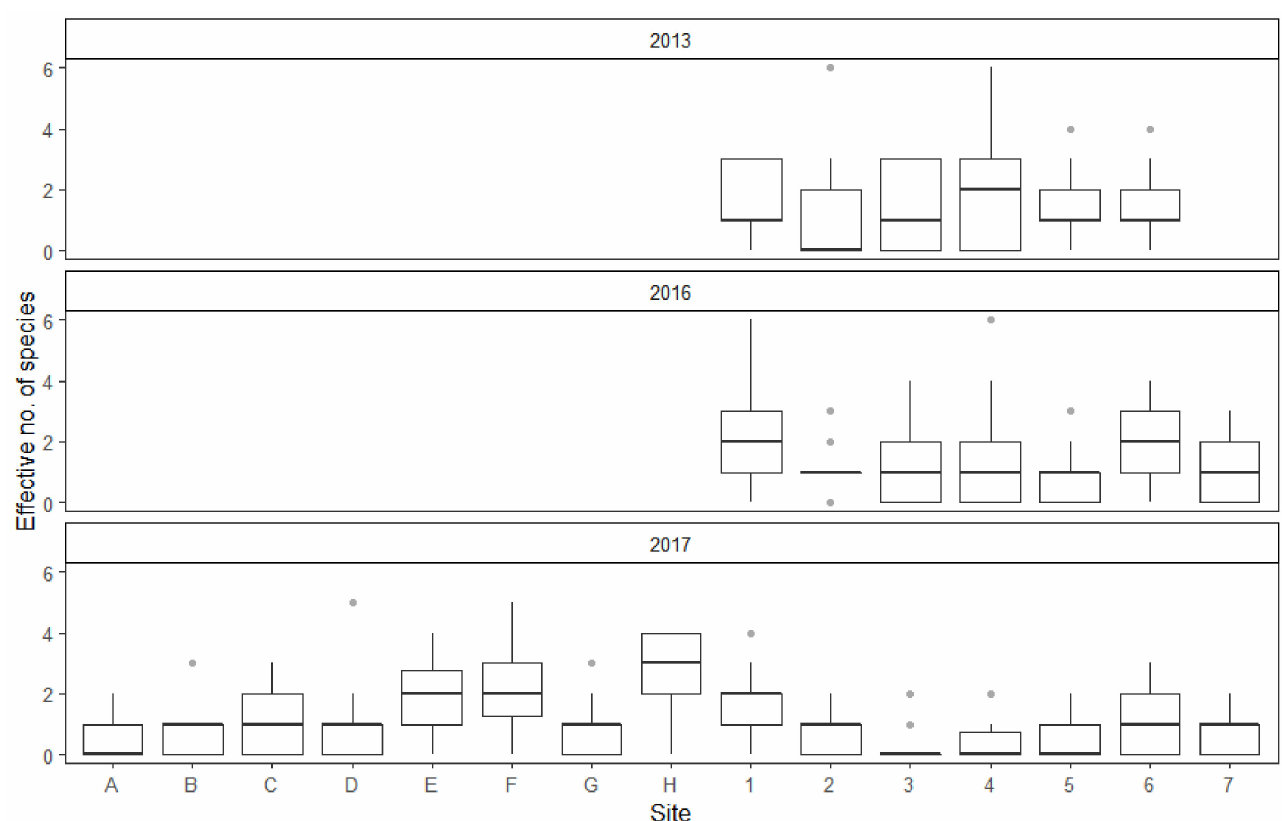
Figure 5. Average effective no. of species (ENS) of each collection site throughout the three study years. Boxplots showing the median (dark line dividing the box), interquartile range (IQR) containing 50% of the data points (length of the box), upper and lower quartiles (whiskers) and outliers (gray